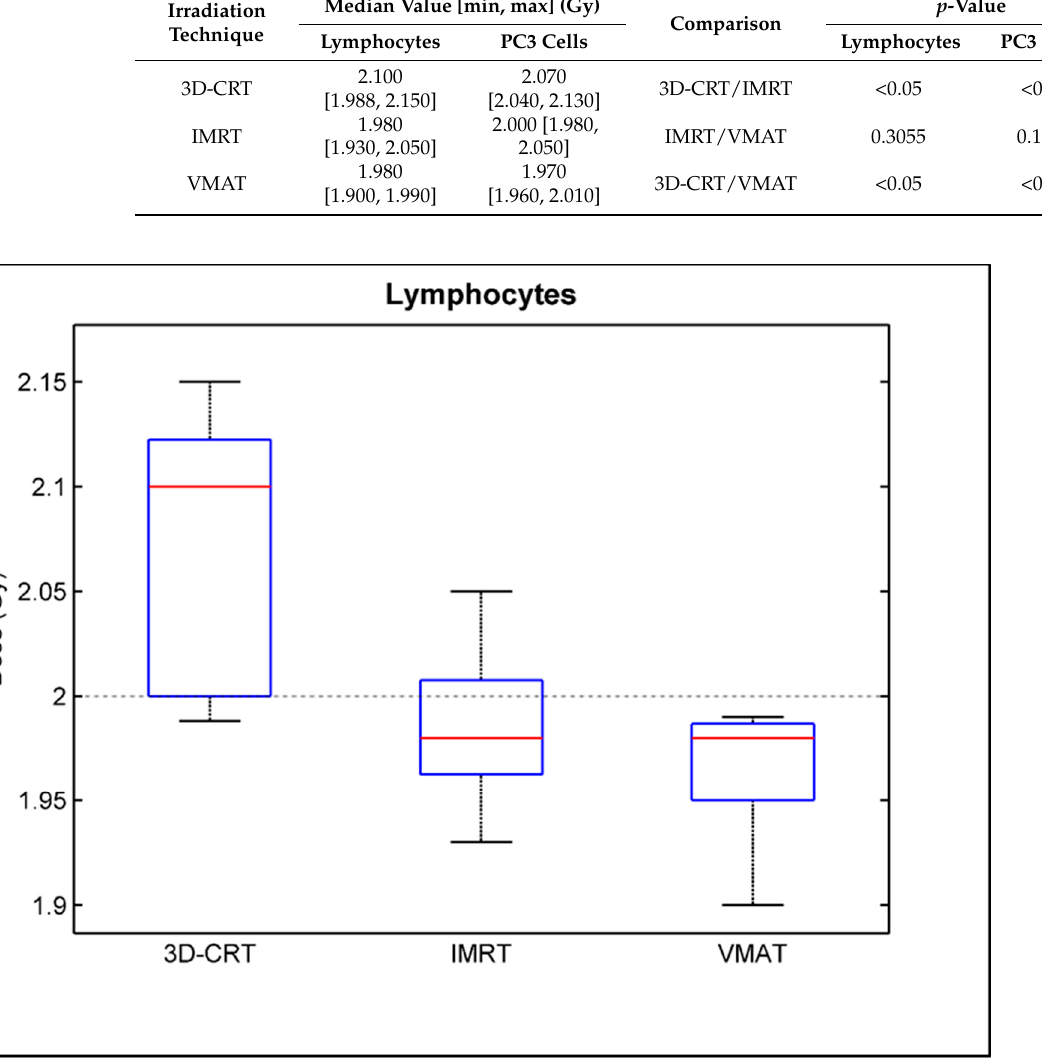
Figure 5. Box and whisker plots of the biological absorbed dose to the peripheral blood lymphocytes irradiated with the 3D-CRT, IMRT and VMAT technique across all prostate cancer patients.